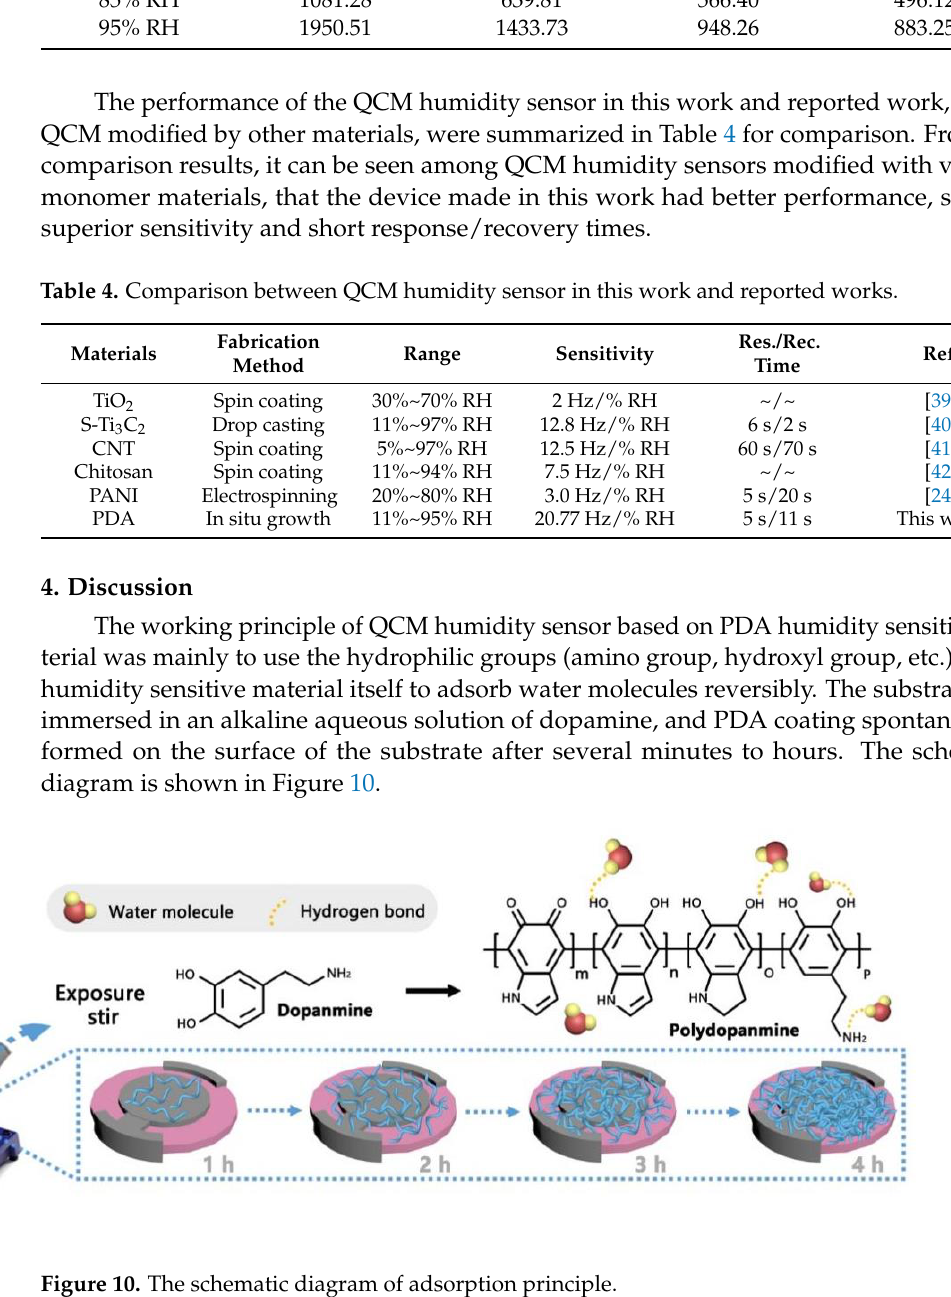
Figure 10. The schematic diagram of adsorption principle.